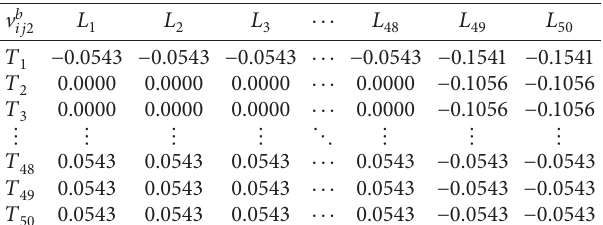
′ � [ d ij ′ ] for 2 2 50 × 50 Table 17: Perceived utility matrix V b transportation